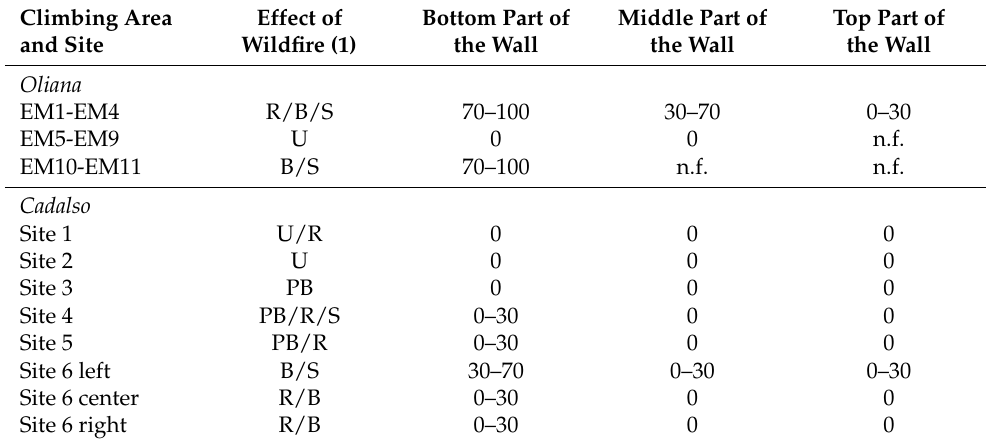
Table 4. Area (%) affected by spalling in climbing areas.